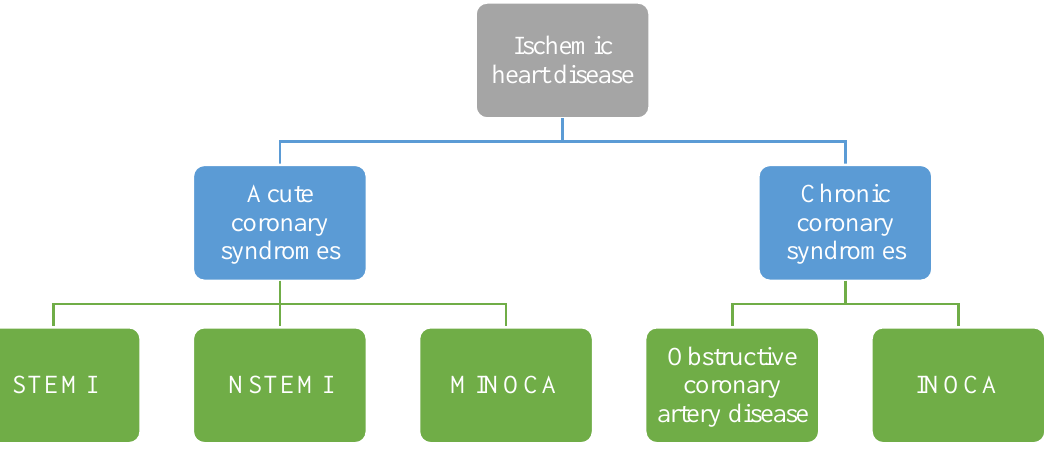
Figure 2. Classification of the various manifestions of ischemic heart disease. Within the well-known obstructive coronary artery disease, the two new entities of INOCA and MINOCA (myocardial infarction with non-obstructive coronary arteries) appear. The term INOCA indicates any condition responsible for myocardial ischemia in the ab- sence of hemodynamically significant coronary lesions (stenosis < 50%) after performing